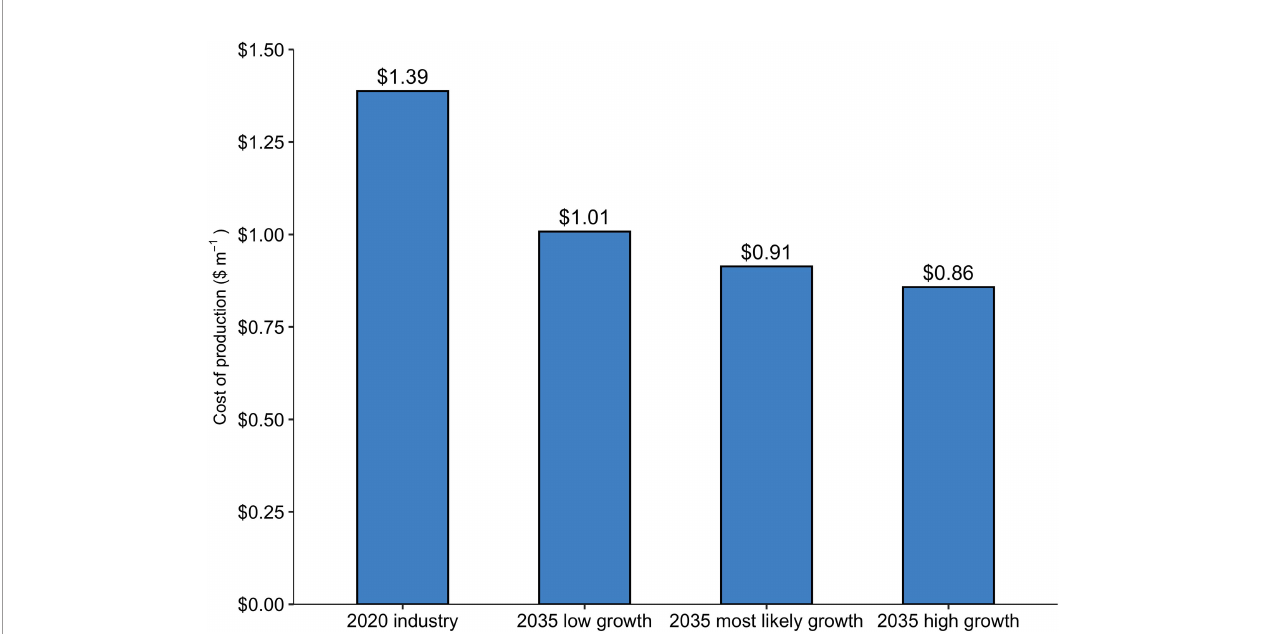
FIGURE 2 | Production costs ($ m twine -1 ; COP) as a function of production scale (m of twine). The “ 2020 industry ” represents a quantity of 101,880 m of twine produced. Based on the projected growth of the Maine kelp industry, the “ 2035 low growth ” , “ 2035 most likely growth ” , and the “ 2035 high growth ” scenarios correspond to quantities of 313,300, 623,000, and 1,214,200 m of twine,